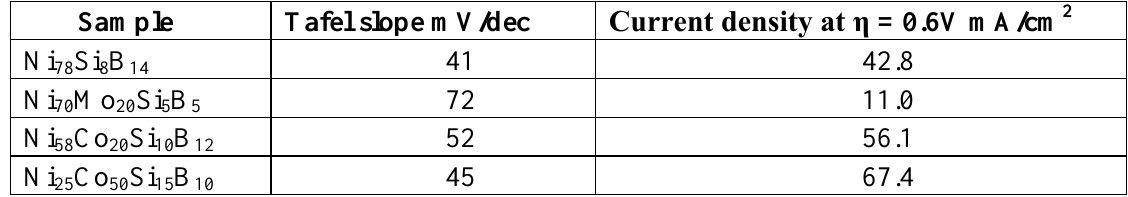
Table 2. Electrochemical data of the OER for the different metallic glasses with